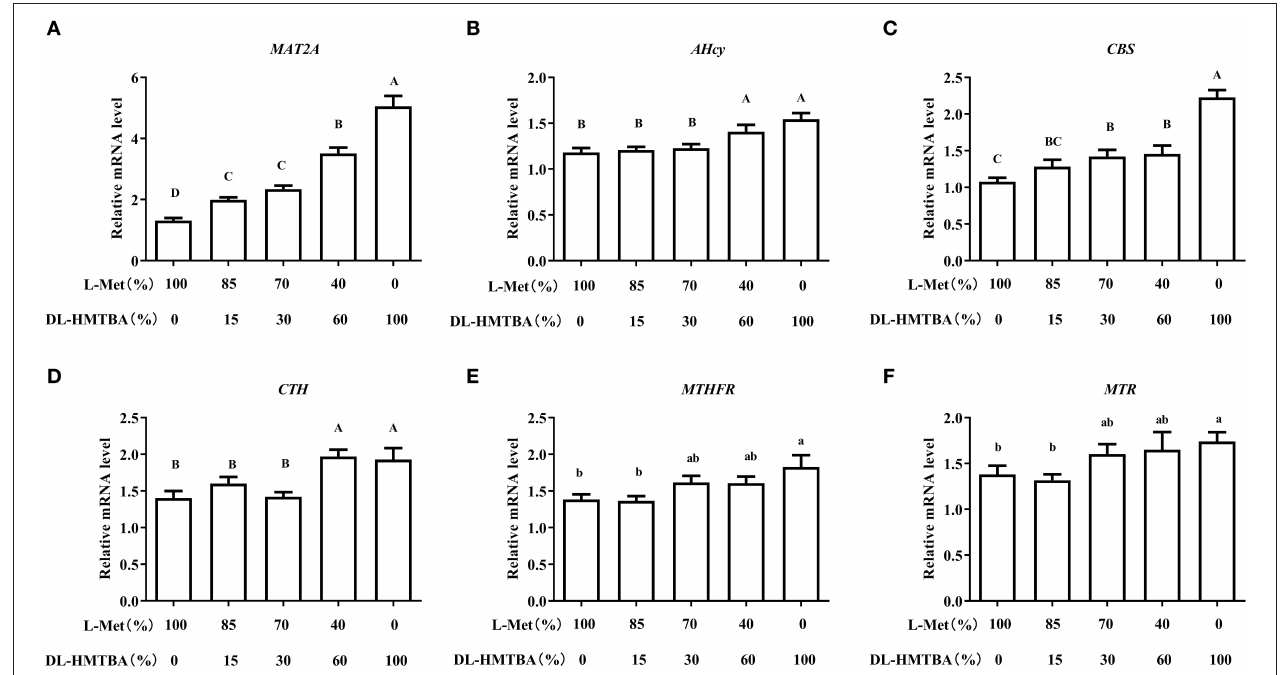
FIGURE 3 | Effects of different ratios of L-Met and DL–HMTBA on mRNA levels of pivotal enzymes about Met metabolism in IPEC-J2 cells. (A) MAT2A: Methionine adenosyltransferase 2A; (B) AHcy: S-Adenosylhomocysteine hydrolase; (C) CBS: Cystathionine-beta-synthase; (D) CTH: Cystathionine gamma-lyase; (E) MTHFR: Methylenetetrahydrofolate reductase; (F) MTR: 5-methyltetrahydrofolate-homocysteine methyltransferase. Cells were cultured without fetal bovine serum for 18h and then without Met for 6h, then, different ratios of L-Met and DL–HMTBA were given for 2h (total methionine source concentration is 5mM). Values are means ± SEM, n = 3; different letters (A–D) mean the difference is extremely significant, p < 0.01; different letters (a,b) mean the difference is signific, p < 0.05.